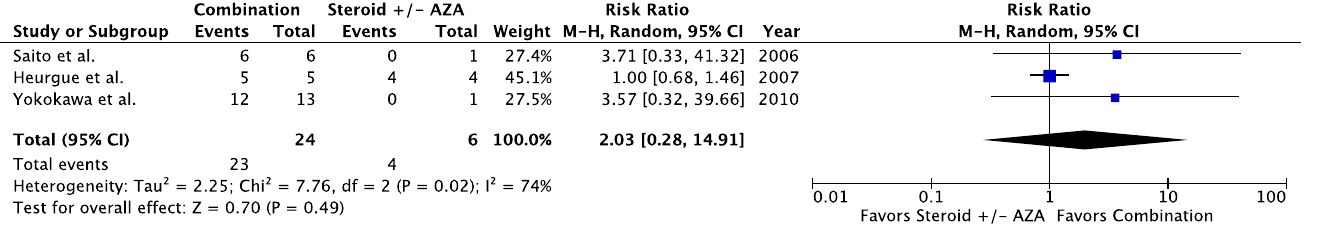
Figure 8. Transplant-free survival in AIH-PBC patients treated with combination therapy vs. immunosuppression. Steroid = corticosteroids, AZA = azathioprine, Combination = UDCA + corticosteroids AZA. Table 3. Results of studies included in systematic review but excluded from meta-analysis.